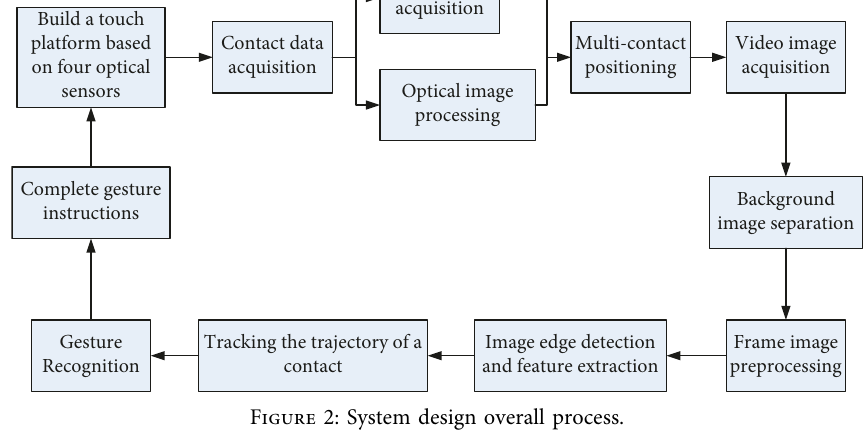
Figure 2: System design overall process.